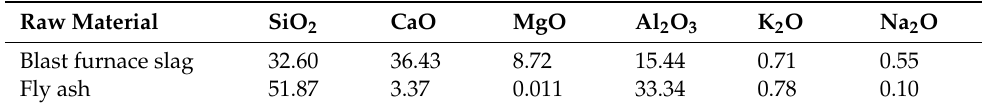
Table 1. Main chemical components of the raw materials (wt.%).